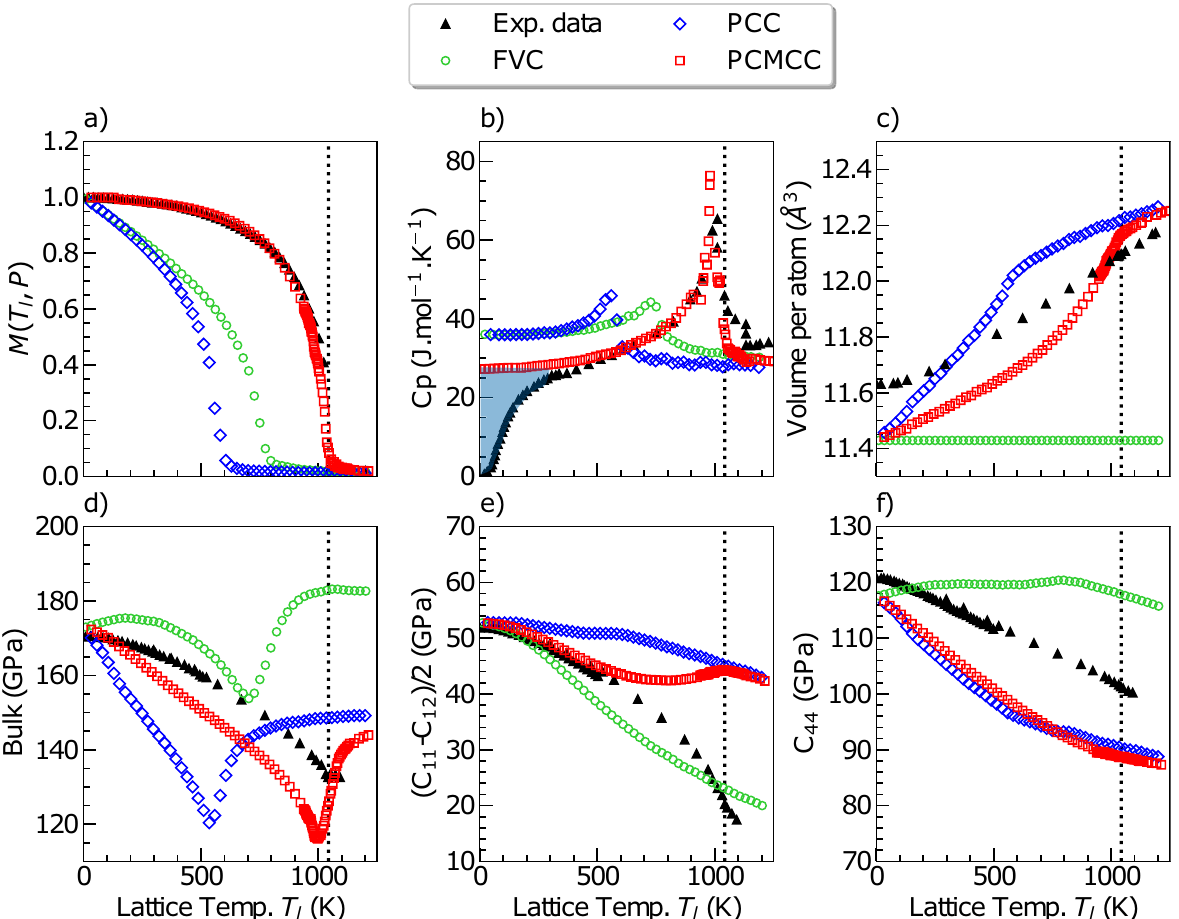
Fig. 4 Magneto-dynamic accuracy results. Plots a – f show magnetoelastic data obtained with our magneto-elastic ML-IAP. The green ( ), blue ( ), and red ( ) markers indicate the choice of equilibration conditions: fi xed-volume conditions (FVC), pressure-controlled conditions (PCC) and pressure-controlled and magnetization-controlled conditions (PCMCC), respectively. In all plots, experimental data (extracted from fi ve different references 87 – 91 ) is denoted by the fi lled triangles ( ▲ ), and the dotted black lines ( ) represent the experimental Curie temperature. The plots in a , b show magnetization and speci fi c heat comparisons between different ensembles and experiments. The light blue region in ( b ) indicates the low temperature regime T ≲ 250 K where quantum effects reduce the experimental heat capacity below the classical Dulong-Petit limiting value of 3 R 45 . The data in plot c illustrates how the lattice expands with temperature. An inherent offset exists between our model (trained to match the DFT data at 0 K) and experimental measurements. Plots d – f show d bulk modulus, e ( c 11 − c 12 )/ 2 shear constant, and f c 44 shear constant for the three aforementioned sets of trends in experiment. Despite these shortcomings, the FVC magnetic energy). Also at low temperature, deviation between calculations actually match the experimental data for shear simulations and experiment (highlighted by the semi-transparent constant ( c 11 − c 12 )/2 relatively well throughout the entire blue region in Fig. 4b) occurs due to quantum effects which reduce the experimental heat capacity below the 3 R value. The temperature range. In general, the fi xed volume assumption FVC heat-capacity is determined at constant volume, although we made under FVC fails to account for thermal expansion, leading to use the symbol C p on the axis label because the enhanced incorrect elastic predictions. We correct this shortcoming of the model by working under simulations described below are indeed conducted at constant PCC ( ) which allows for thermal expansion. As can be seen on pressure conditions. In those constant volume conditions, the pressure evolution with temperature increase is substantial (up to Fig. 4c, the cell volumes are relaxed at each fi nite temperature, 12 GPa, almost corresponding to the α → ϵ transition, as can be until the pressure in the system drops to ~0 GPa. As shown in Fig. seen on Fig. 6), which has a strong impact on the underlying 4a, the thermal expansion incorrectly moves the onset of Curie elastic properties. Interestingly, at the Curie temperature (here transition to ~536 K. As the average interatomic distance 716 K), the increasing pressure exhibits an in fl ection point, increases, the strength of the exchange interaction is lowered, con fi rming the importance of spin fl uctuations on the thermo- thus decreasing the transition temperature. The computed heat- elastic properties. The temperature dependence of three elastic capacity (Fig. 4b) now corresponds to the derivative of the free constants is shown in Fig. 4d – f. For the bulk modulus, FVC does energy, and to an actual C p measurement. However, as in the FVC, not agree well with experimental data, especially at higher the low agreement between the experimental and computed temperatures. The FVC results tend to overestimate the stiffness, magnetization evolution leads to an offset in the initial C p and which most likely arises from the build-up of thermal stresses in does not match the Dulong-Petit value at low temperature. The the material. Under these conditions a nearly temperature- PCC fares better in reproducing the experimental bulk modulus up invariant c 44 response is predicted, which is in strong contrast to to the Curie transition (no hardening observed). PCC also does